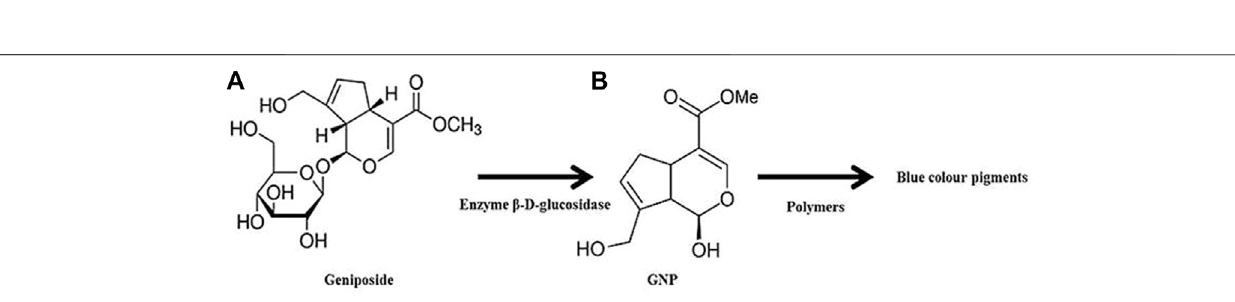
FIGURE 3 | Type of crosslinking approaches. Generally, there are four categories of crosslinking methods: physical, chemical, enzymatical, and natural.